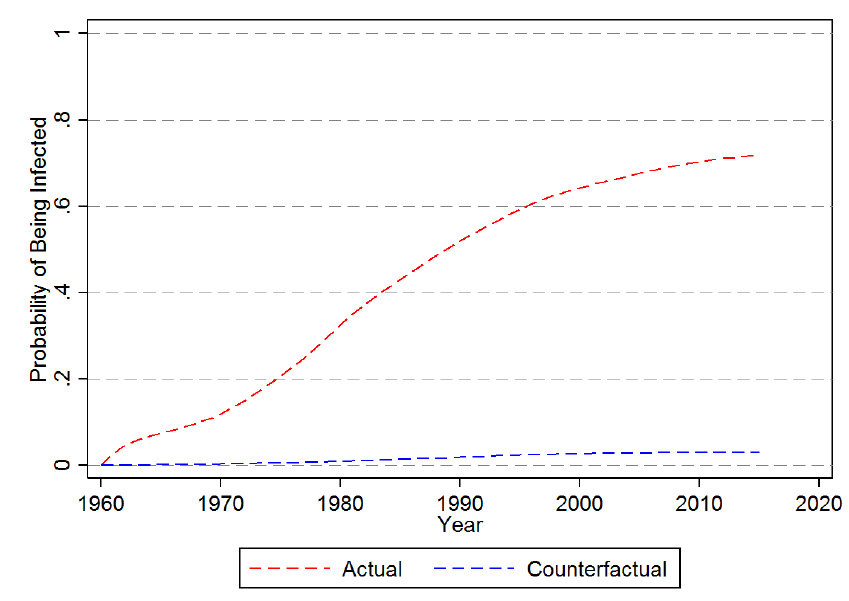
Figure 6. Probability of First Time Infection—No Agricultural Imports. Note: This figure provides the counter-factual prediction of the impact assuming no agricultural imports as estimated from the Cox Proporational Hazard Model in Equation